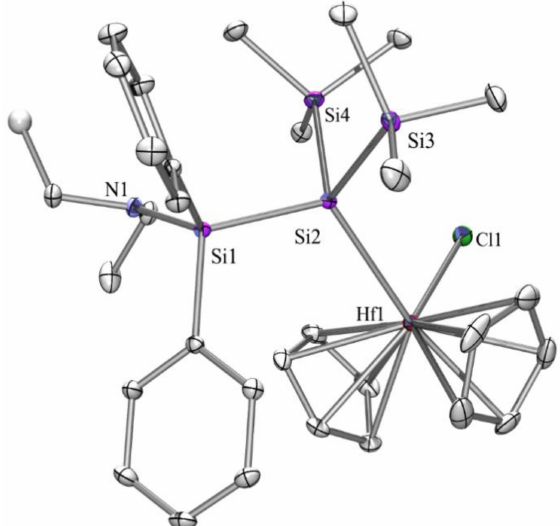
Figure 6. Molecular structure of 3b (thermal ellipsoid plot drawn at the 30% probability level). All hydrogen atoms are omitted for clarity (bond lengths in Å, angles in degrees). Hf(1)-Cl(1) 2.3998(8), Hf(1)-Si(2) 2.8339(8), Si(1)-Si(2) 2.3937(9), Si(1)-N(1) 1.7315(19), Si(1)-C(17) 1.891(2), Cl(1)-Hf(1)-Si(2) 93.12(3), Si(3)-Si(2)-Si(1) 103.81(4), Si(3)-Si(2)-Hf(1) 117.25(3), Si(1)-Si(2)-Hf(1) 119.29(3), N(1)-Si(1)-Si(2)